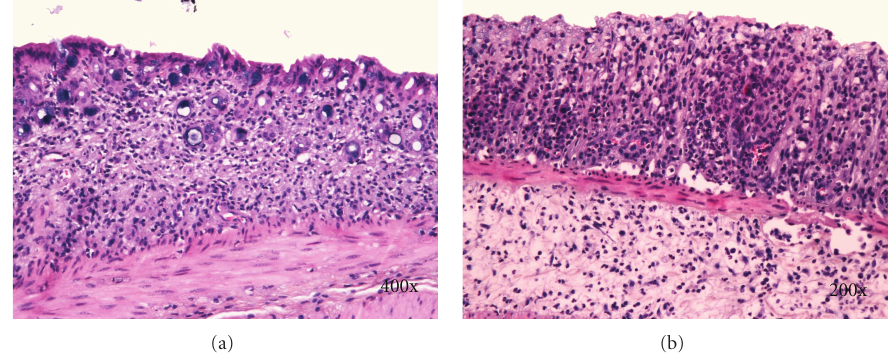
Figure 2: (a) Disappearance of crypts. (b) Erosion and phlegmonous inflammation of mucosa and submucosa. Kreyberg trichrom stain (acid mucopolysaccharides are stained blue). C57BL/6JOlaHsd female mice are exposed to 3% DSS solution for 5 days followed by drinking water for 7 days.